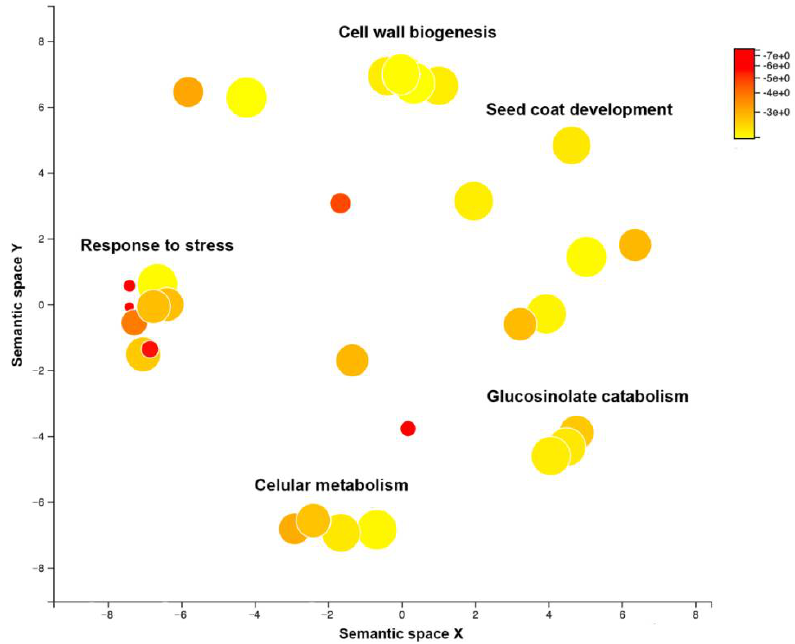
Figure 3. Scatterplot of enriched gene ontology (GO) terms for Arabidopsis determinants of CMV virulence. Color scale indicates significance of the term enrichment (−log 10 ( p ). Dot diameter indicates fold enrichment.